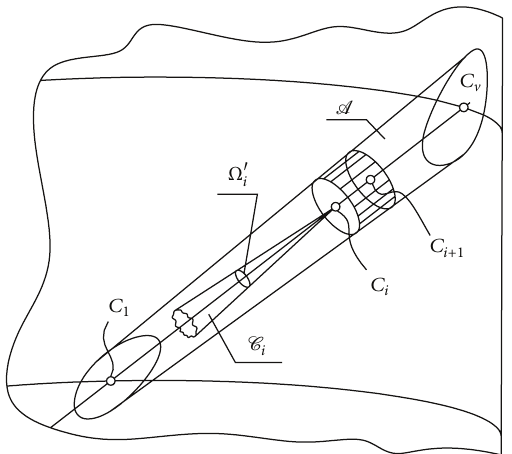
Figure 4: The portions of light tubes A and C 𝑖 in the radiating cylinder.